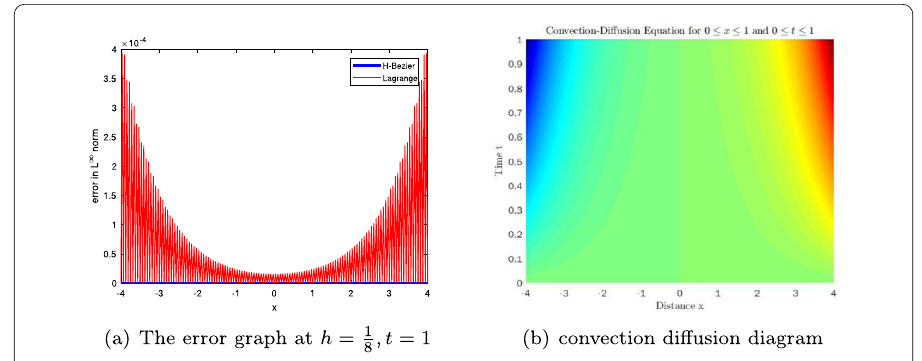
Figure 9 The error graph and convection diffusion diagram